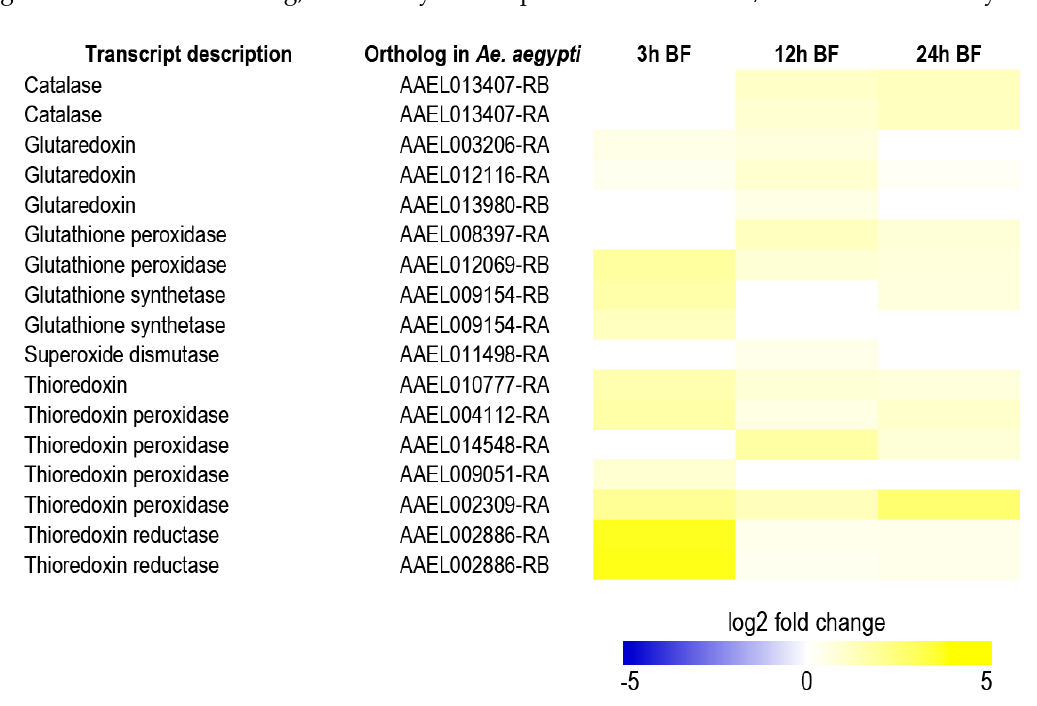
Figure 10. Heat map of transcripts encoding antioxidant enzymes that are significantly up-regulated in the Malpighian tubules of blood fed (BF) adult female Ae. albopictus . The log2 fold changes in transcript expression are indicated by the provided color scale and are relative to Malpighian tubules of non-blood fed mosquitoes. Data are from [12].